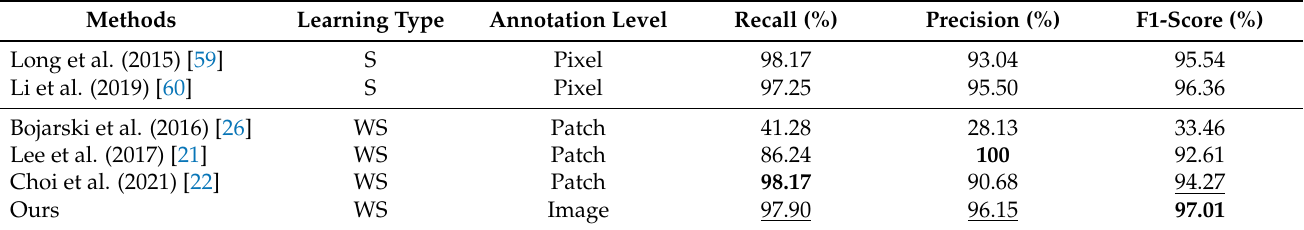
Table 1. Quantitative comparison with other methods. The best result is highlighted in bold, and the second-best result is underlined. S and WS indicate supervised learning and weakly supervised learning,